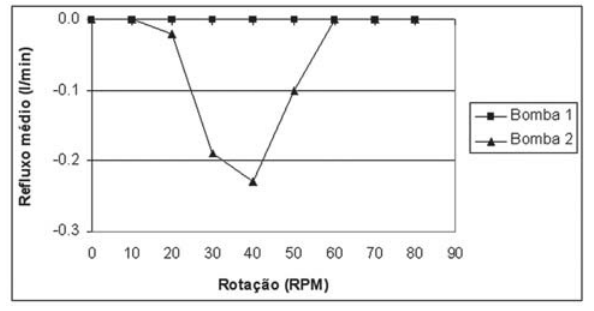
Fig. 8 – Refluxo médio pela rotação nos modelos de bomba#1 e #2 em reservatório de cardiotomia. Fluído análogo ao sangue. Bombas ajustadas com oclusão total e Rtot = 250 ± 3